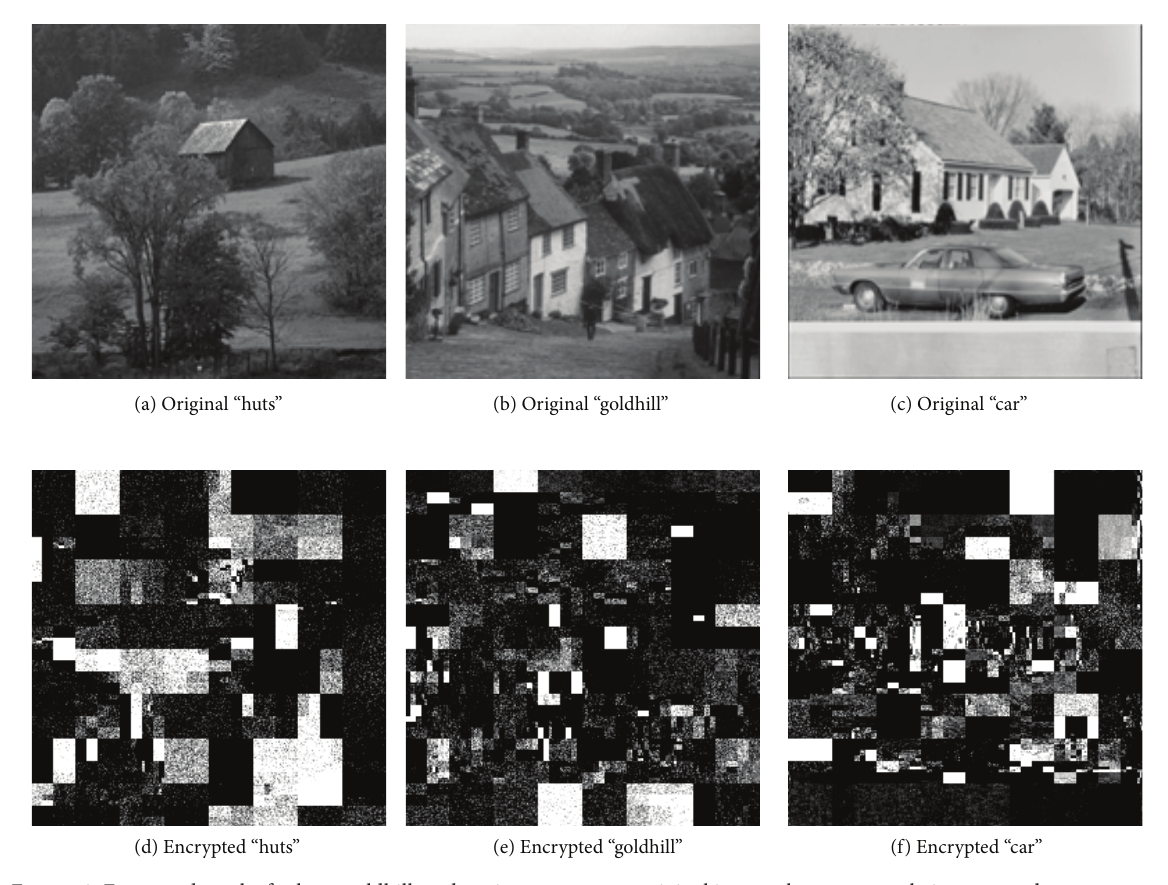
Figure 2: Encrypted results for huts, goldhill, and car image; top row: original images, bottom row: their encrypted counterparts.